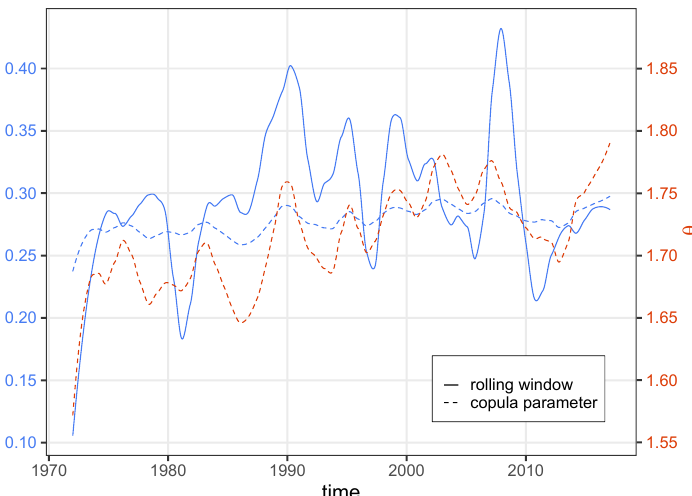
Figure 9. Rolling-window Kendall’s τ between S and H S (solid blue line), copula parameter θ (dashed red line) and the corresponding copula τ (dashed blue line). The rolling window has a duration of 365 days; thus, the first year of observation (1971) is not displayed. The time-series were smoothed with LOESS with a span of 5/45 (i.e., a span of 5 years, which was selected for